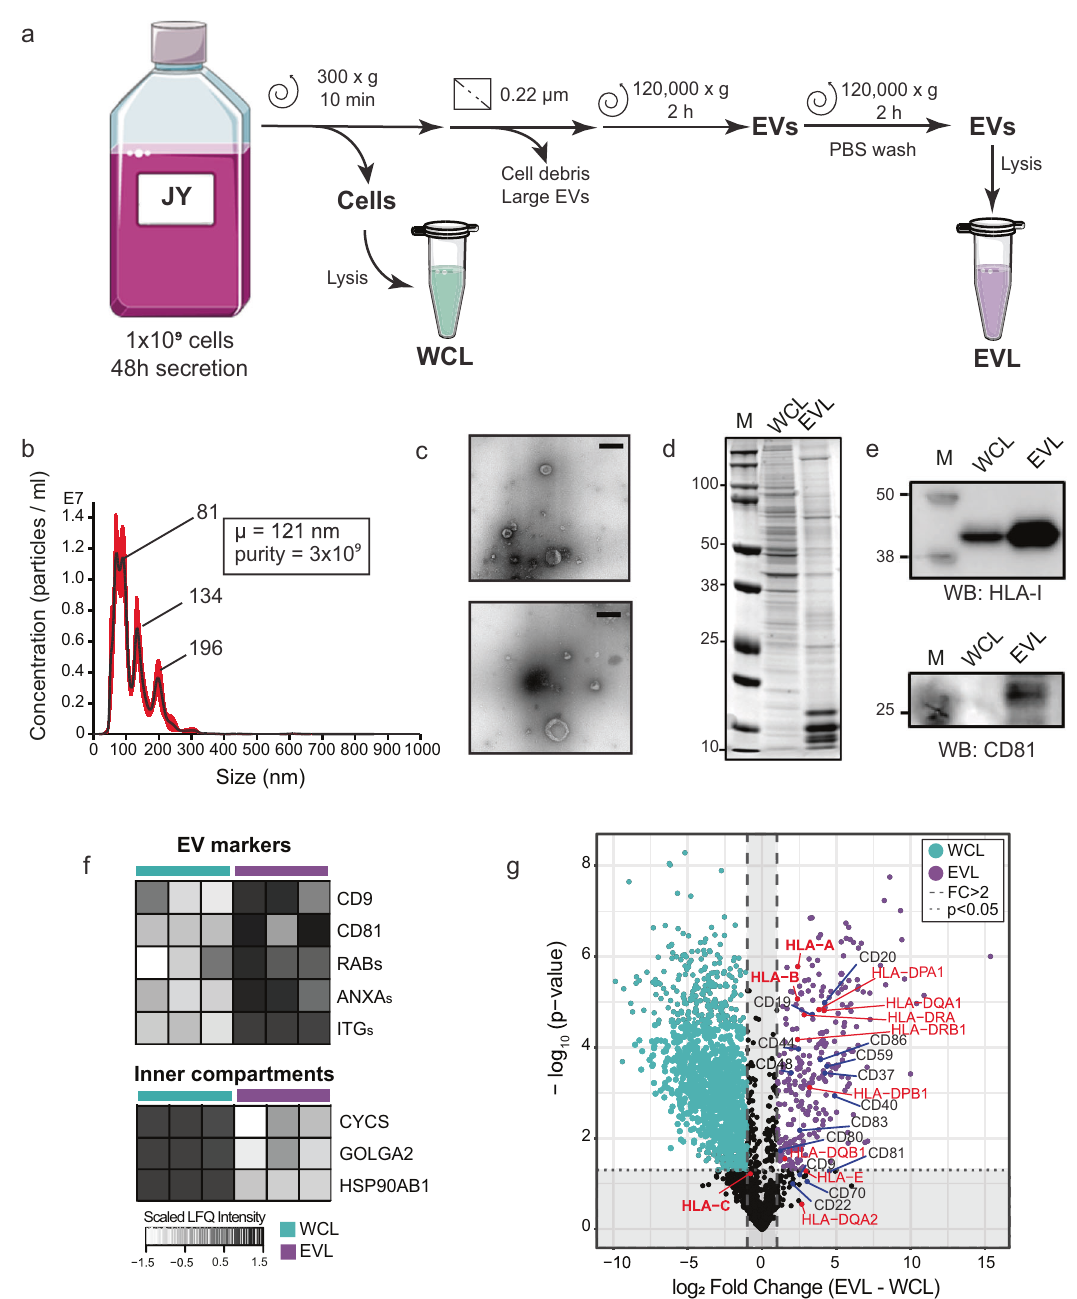
Fig. 1 Extracellular vesicle isolation and characterization. a Schematic work fl ow of extracellular vesicle (EV) isolation. Lysates made from JY WC (WCL, green) and JY-derived EVs (EVL, purple) were used subsequently as input for immunoaf fi nity puri fi cation of HLA complexes (Figs. 2 – 4). b Nanoparticle tracking analysis (NTA). Size and concentration of isolated EVs were estimated. Purity (particle:protein ratio) of EVs was 3e9, with mean particle size of 121 nm. Representative trace. c Negative stain transmission electron microscopy (NS-TEM) analysis. Morphology of the isolated EVs were cup-shaped. Representative images. Scale bar: 200 nm. Full images provided in Supplementary Fig. 6. d SDS-PAGE of protein band patterns in WCL and EVL. Dominant protein bands in WCL and EVL were mutually exclusive. Full image provided in Supplementary Fig. 7. e HLA-I and cd81 western blot. From 5 µ g load of EVL and WCL, prominent enrichment of HLA-I and CD81 were observed in EVL. Full images provided in Supplementary Fig. 8. f Quantitative proteomics analysis of WCL ( n = 3) and EVL ( n = 3). Numerous classical EV markers were enriched in EVL. g Quantitative proteomics comparison of EVL and WCL. HLA proteins, numerous cell surface CD proteins and tetraspanins were signi fi cantly enriched in EVL. Dashed lines indicate proteins with a 2-fold change in abundance, while dotted lines indicate proteins with p value ≤ Performing HLA class I peptide ligandome experiments from a proteins from equal input (120 µg) of JY whole-cell lysate or minute amount of EV material required a drastic down-scaling EV lysate. Despite using a much-reduced starting input compared (~20×) of our established work fl ow 24 , as it was not feasible to to most other reports of HLA peptide pro fi ling, we did not obtain milligrams of EVs in contrast to WC. With an adapted compromise on puri fi cation stringency. As shown in Fig. 2b, high sensitivity work fl ow, we immunoprecipitated HLA-I more than 80% of all detected ligands were predicted to bind